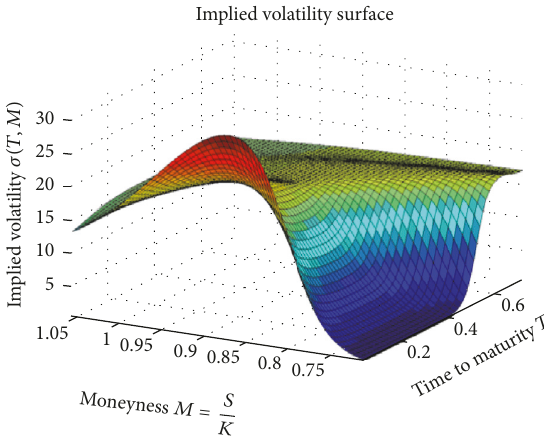
Figure2:OptionsonS&PTSX60January10,2011,impliedvolatility